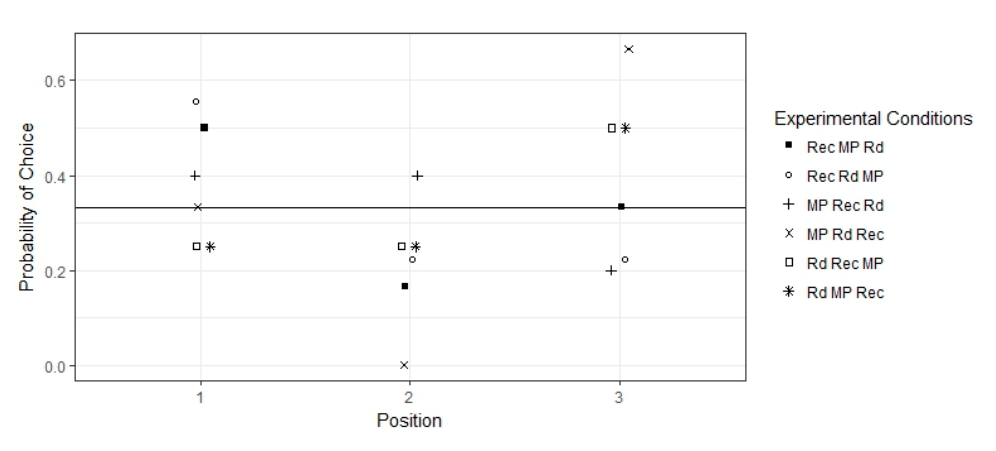
Figure 3. Sample probability of choosing each position on the screen display across the experimental conditions.